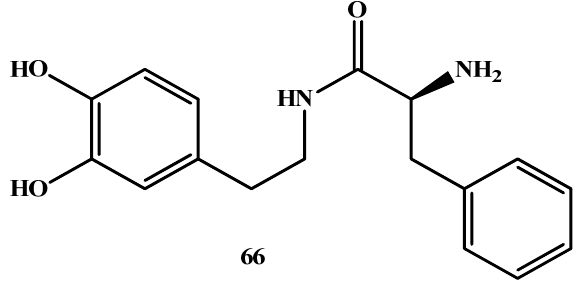
Figure 10. Structure of 2-amino- N -[2-(3,4-dihydroxy-phenyl)-ethyl]-3-phenylpropionamide (DA-PHEN), 66 .